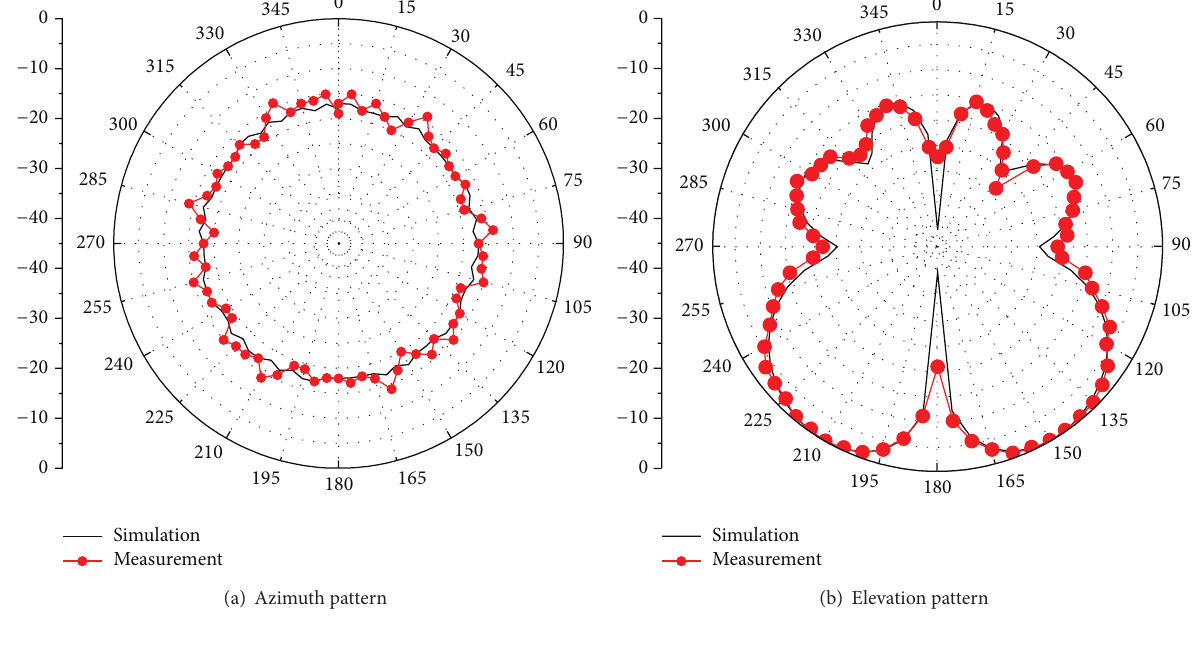
Figure 8: Simulated and measured radiation patterns from configuration III at 5.8 GHz.